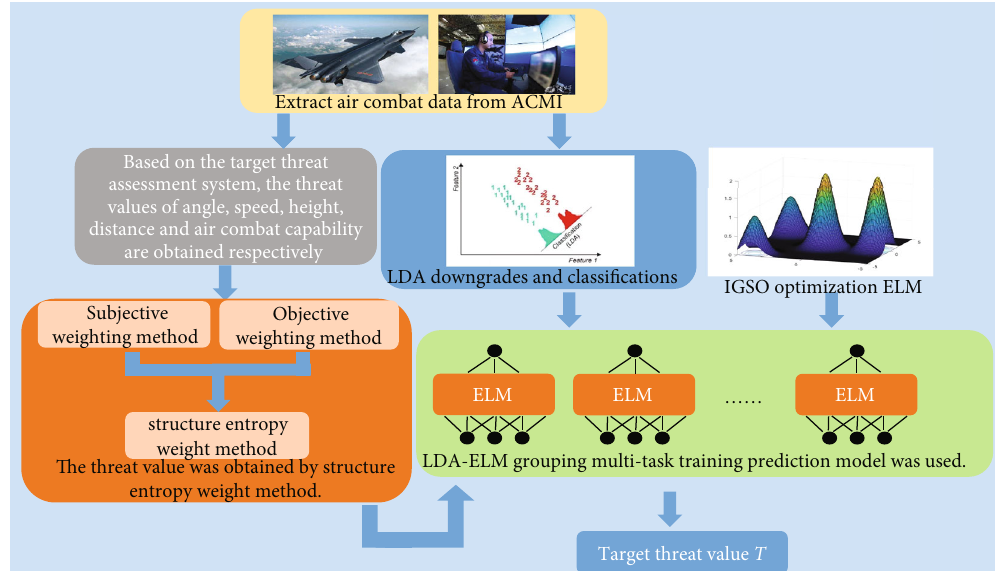
Figure 3: Structure diagram of target threat assessment model.